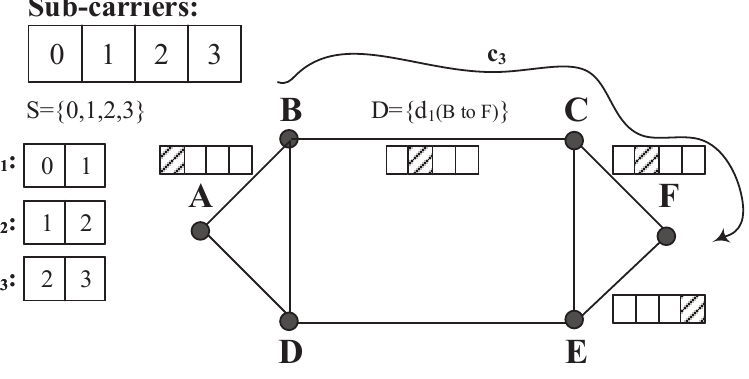
Figure 1. An Example of a Six-Node